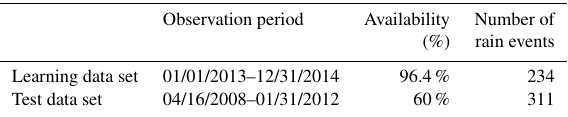
Table 1. Observation periods, availability of DBS observations and numbers of rain events for the learning and test data